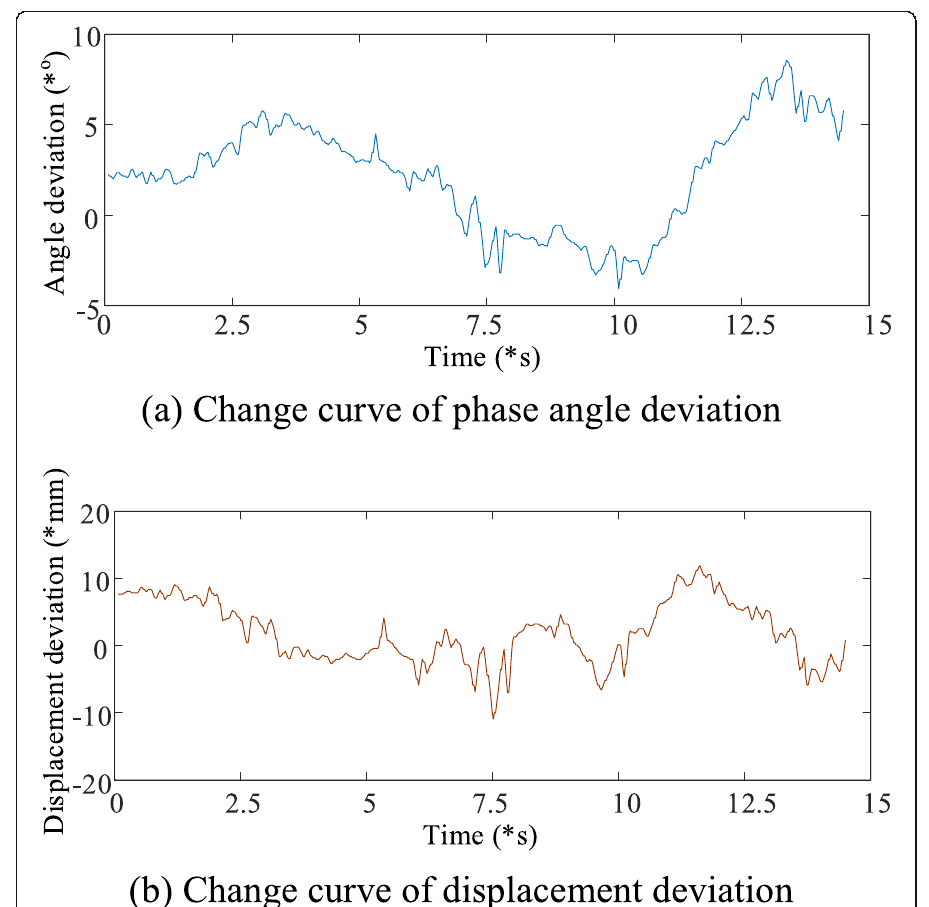
Fig. 13 Motion curve of typical scene 6. a Change curve of phase angle deviation. b Change curve of displacement